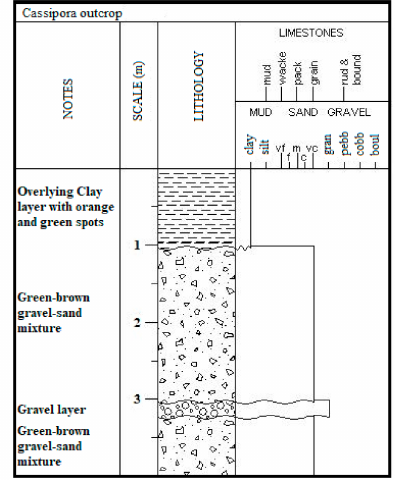
Figure 9. Sediment log of the outcrop at